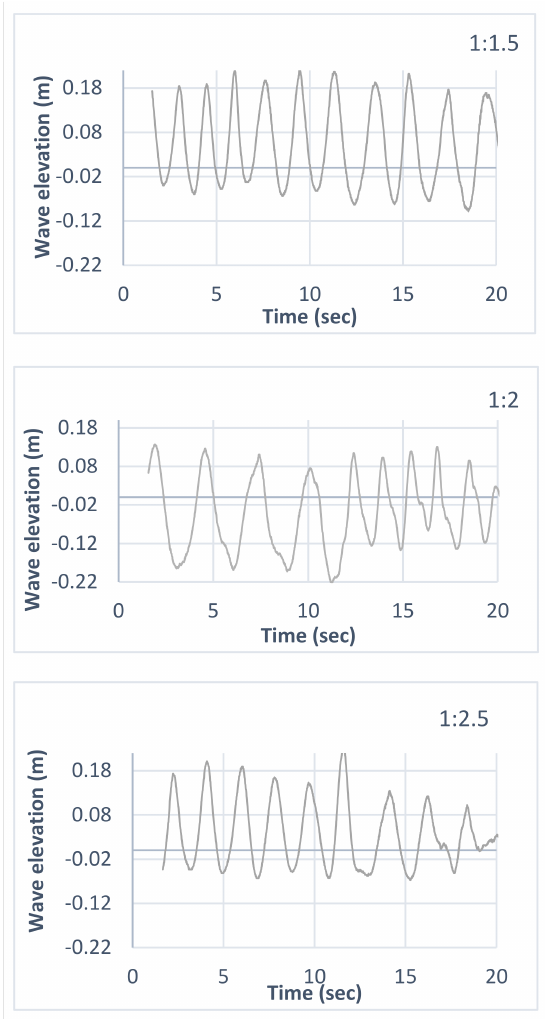
Figure 7. Wave envelopes for